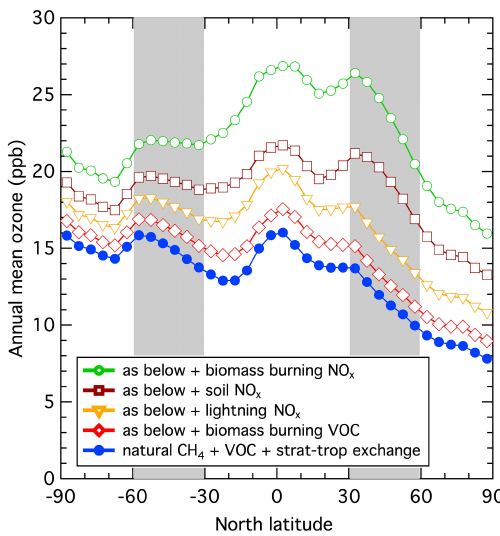
Figure 1. Pre-industrial latitude dependence of zonal surface an- nual mean ozone mixing ratios calculated by the STOCHEM-CRI for progressively larger assumed NO x emission scenarios. The base case assumes a pre-industrial methane mixing ratio of 718ppb, to- gether with 506Tgyr − 1 isoprene and 126Tgyr − 1 terpene emis- sions. The shaded regions indicate midlatitudes. The assumed nat- ural NO x emissions are 0.6TgNyr − 1 for stratosphere–troposphere exchange, 5.0TgNyr − 1 for lightning, 5.6TgNyr − 1 for soils and 6.8TgNyr − 1 for biomass